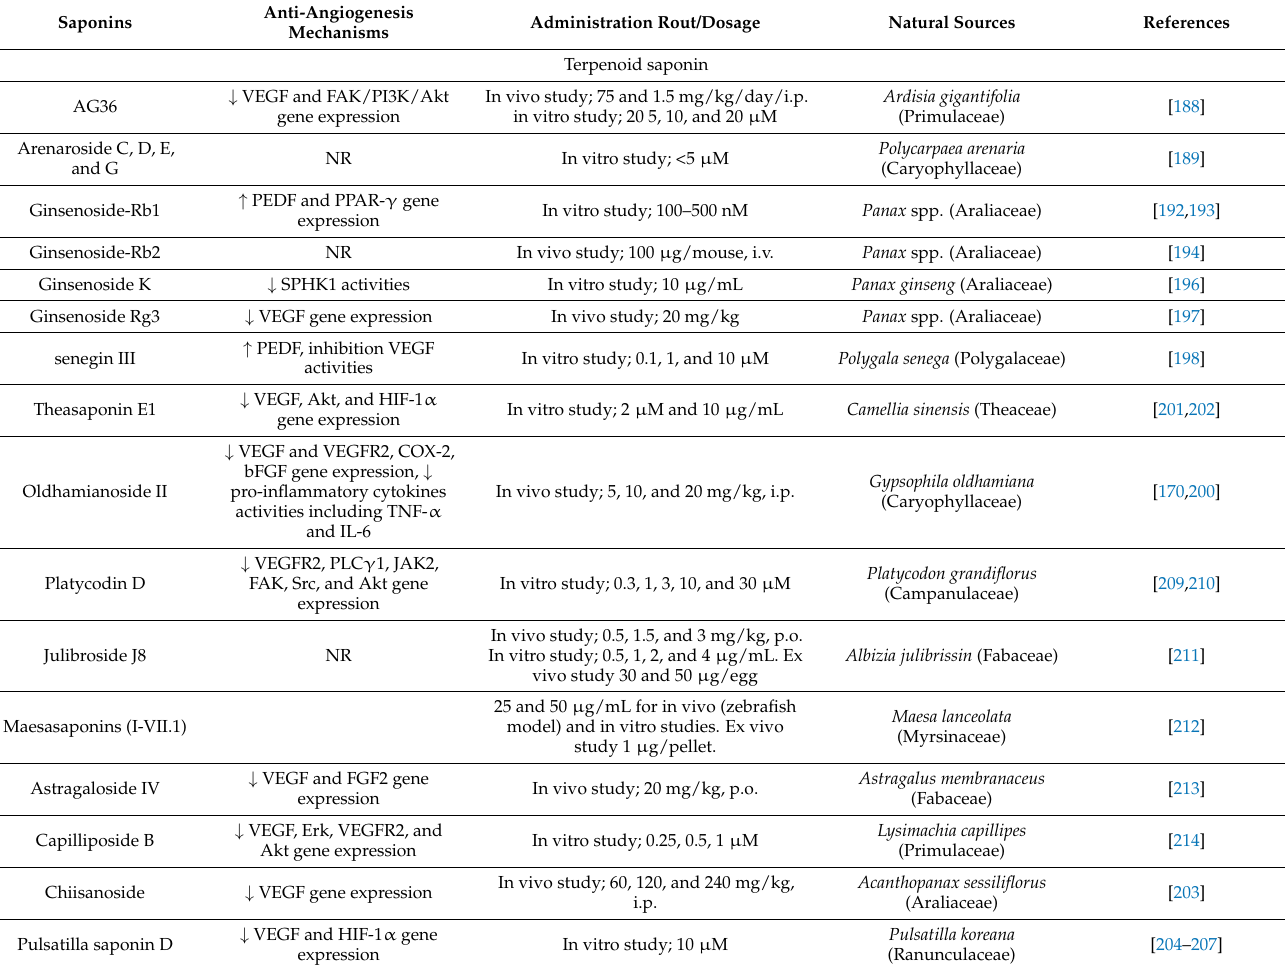
Table 1. Terpenoid and steroidal saponins with anti-angiogenesis